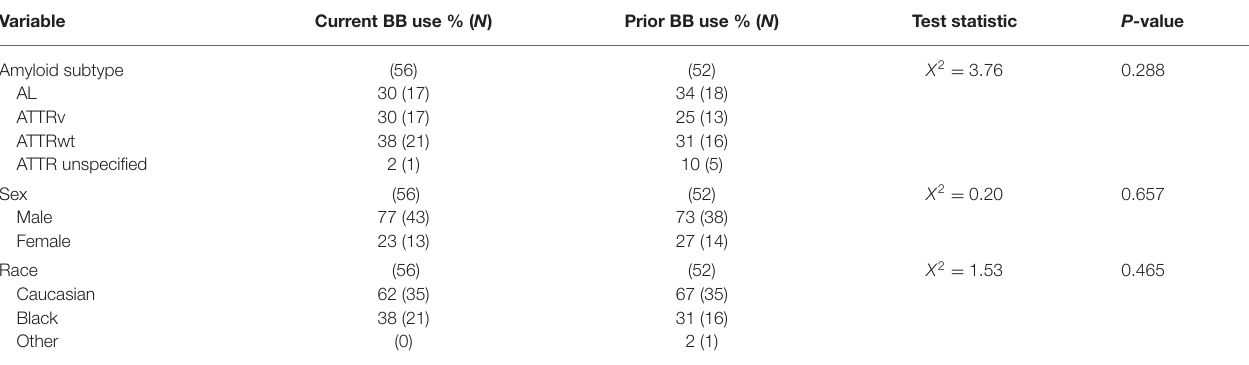
TABLE 3 | Comparison of demographic variables compared between patients with current vs prior beta blocker categories. Variable